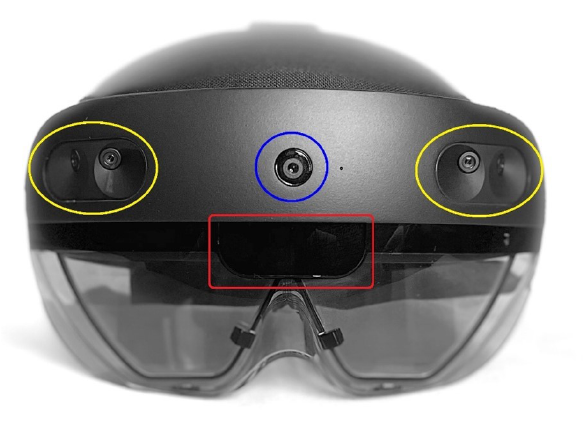
Figure 3. HoloLens 2.0 camera configuration. ( yellow ) Grayscale tracking cameras. ( Red ) ToF camera. ( Blue ) RGB